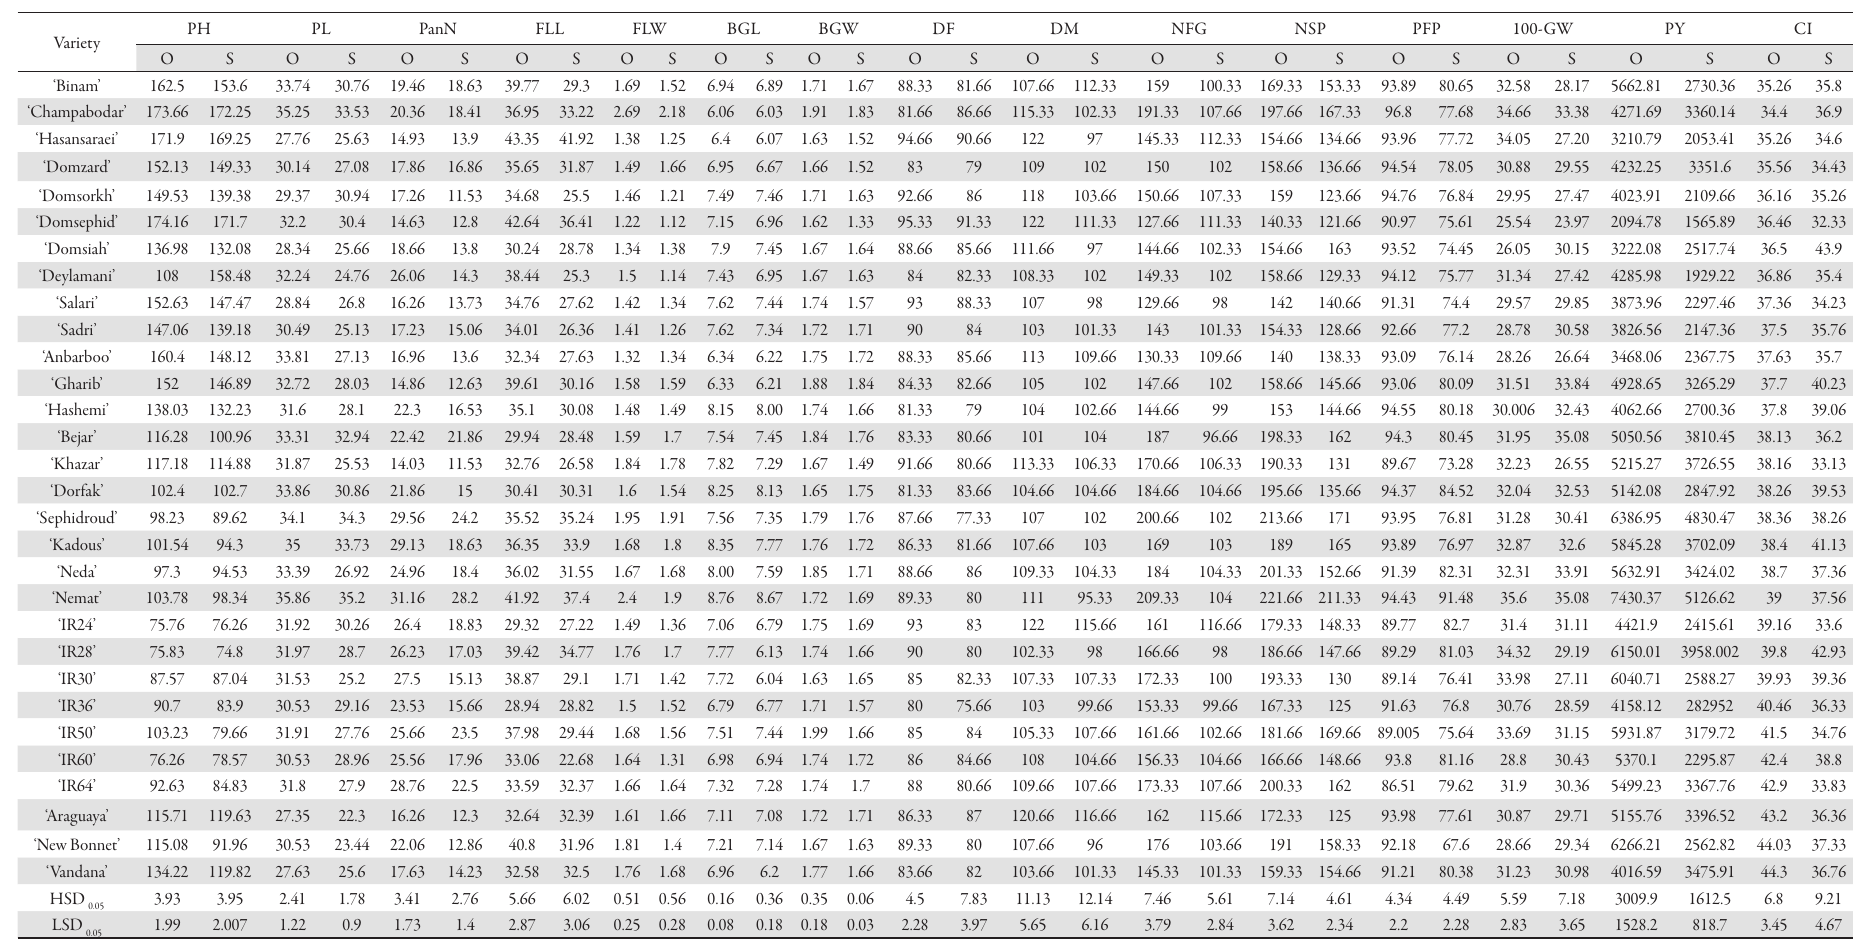
Tab. 2. Mean of 30 rice varieties for measured traits under two irrigation regimes, optimum irrigation (O) and drought stress